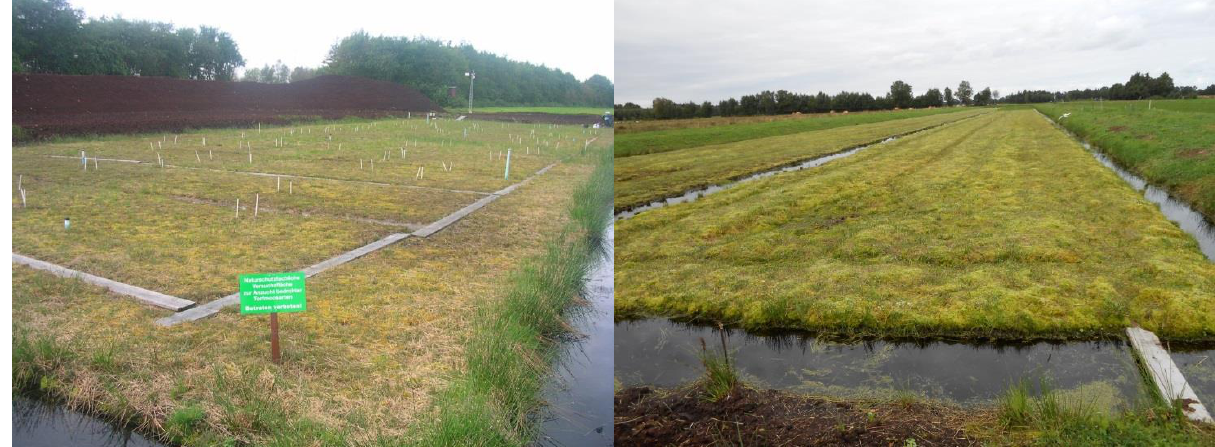
Figure 1. The Ramsloh Test Field in October 2007 (left) and the Hankhausen Test Field in September 2012 (right). Photos: Silke